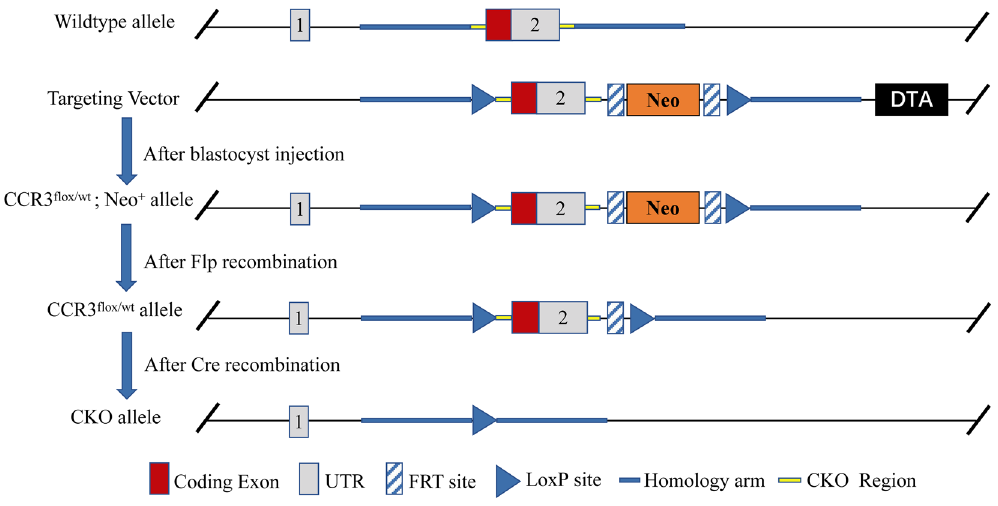
Figure 5. Construction strategy for the CCR3 −/− (CKO)